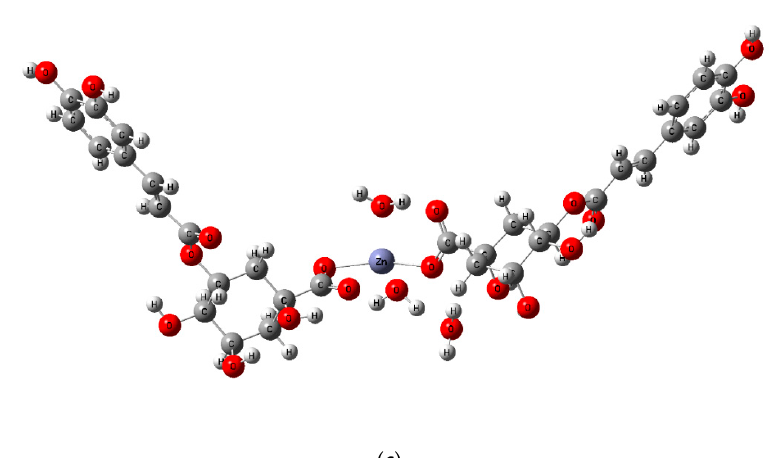
Figure 6. ( a ) The structure of 5-CQA with atom numbering, ( b ) Zn 5-CQA structure I and ( c ) structure II; calculated at B3LYP/6-31G(d) level. The structure I of Zn 5-CQA (b) can be transformed into two different phenoxyl radicals with the participation of: –OH of the catechol group engaged in the Zn 2+ coordination; –OH from the free catechol group.